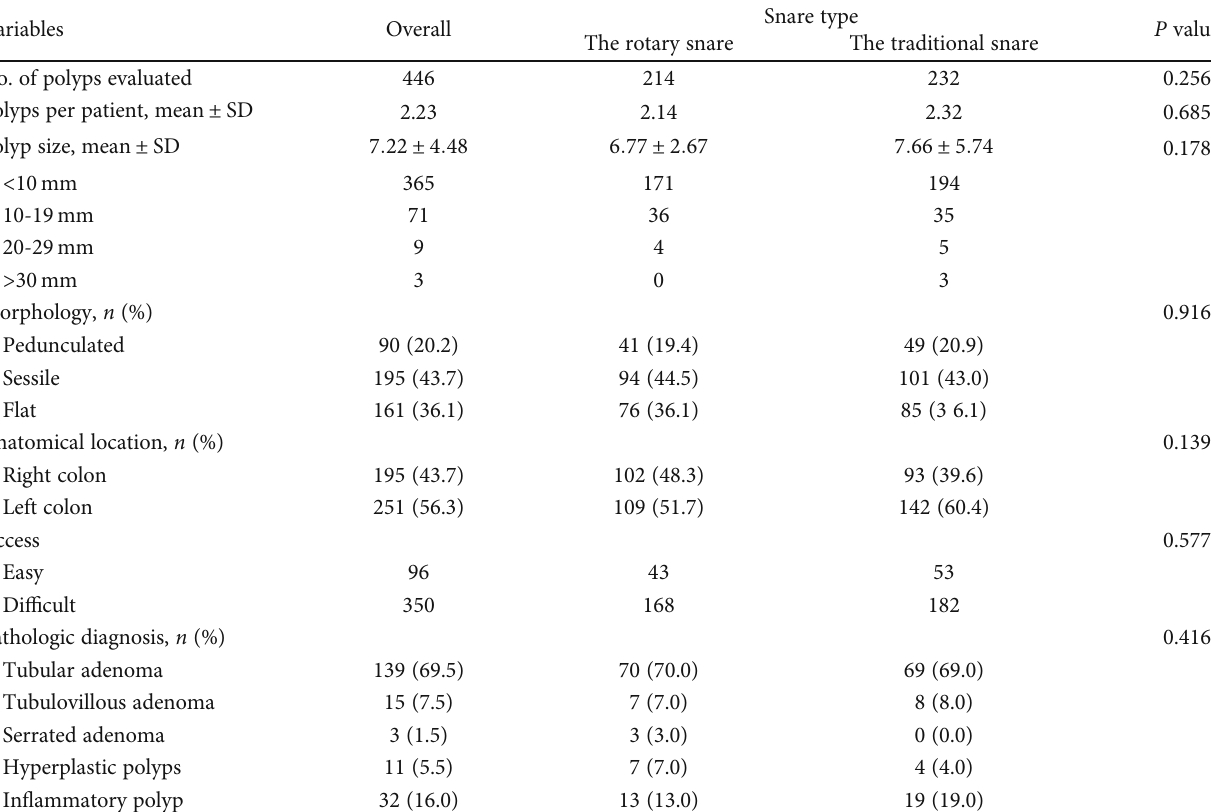
Table 2: The characteristics of evaluated